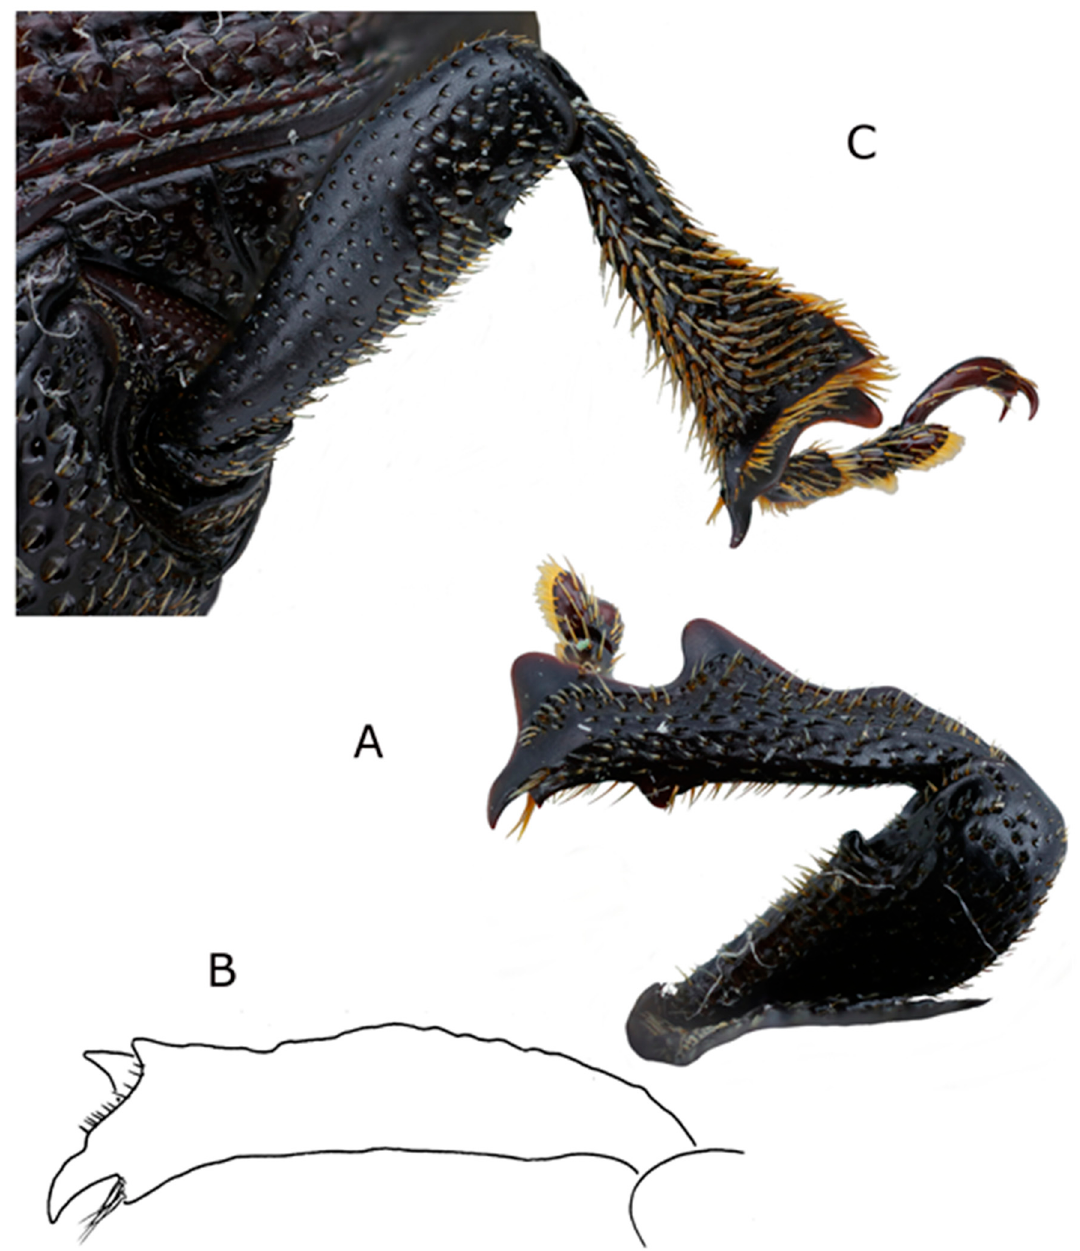
Figure 6. Sclerocardius africanus (Boheman): ( A ) fore tibia, male right showing postero-ventral tooth, ( B ) mid tibia, right antero-dorsal, and ( C ) hind tibia left anterior. Thorax. Pronotum with length:width 0.83–1.00 (mean 0.89, n = 17), higher than long when length is